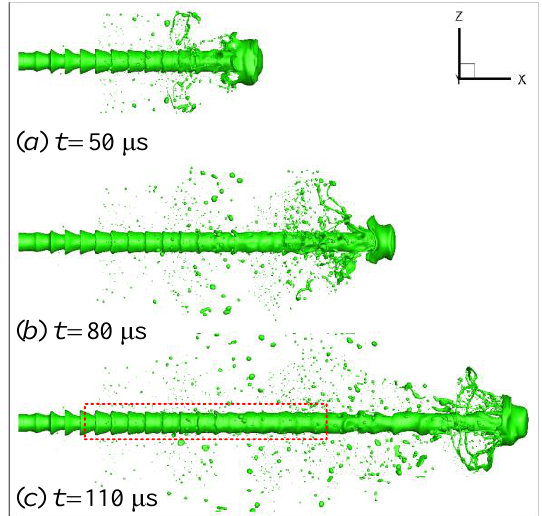
Figure 6. Evolution of jet surface waves at f = 300 kHz.